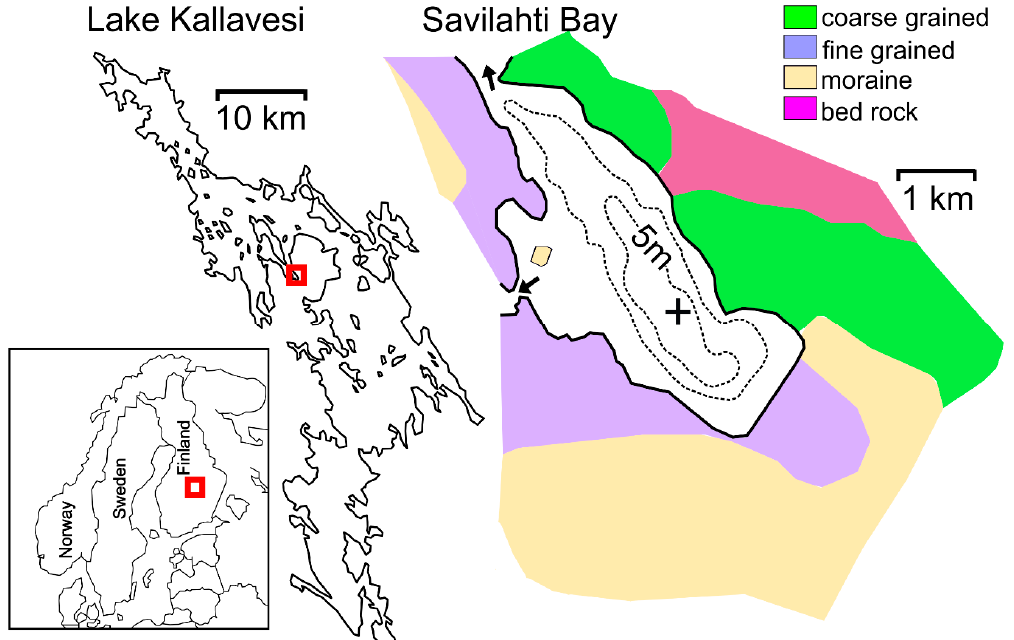
Figure 1. Location of Savilahti Bay and the online sediment trap site in the deepest part of the basin (marked with +).